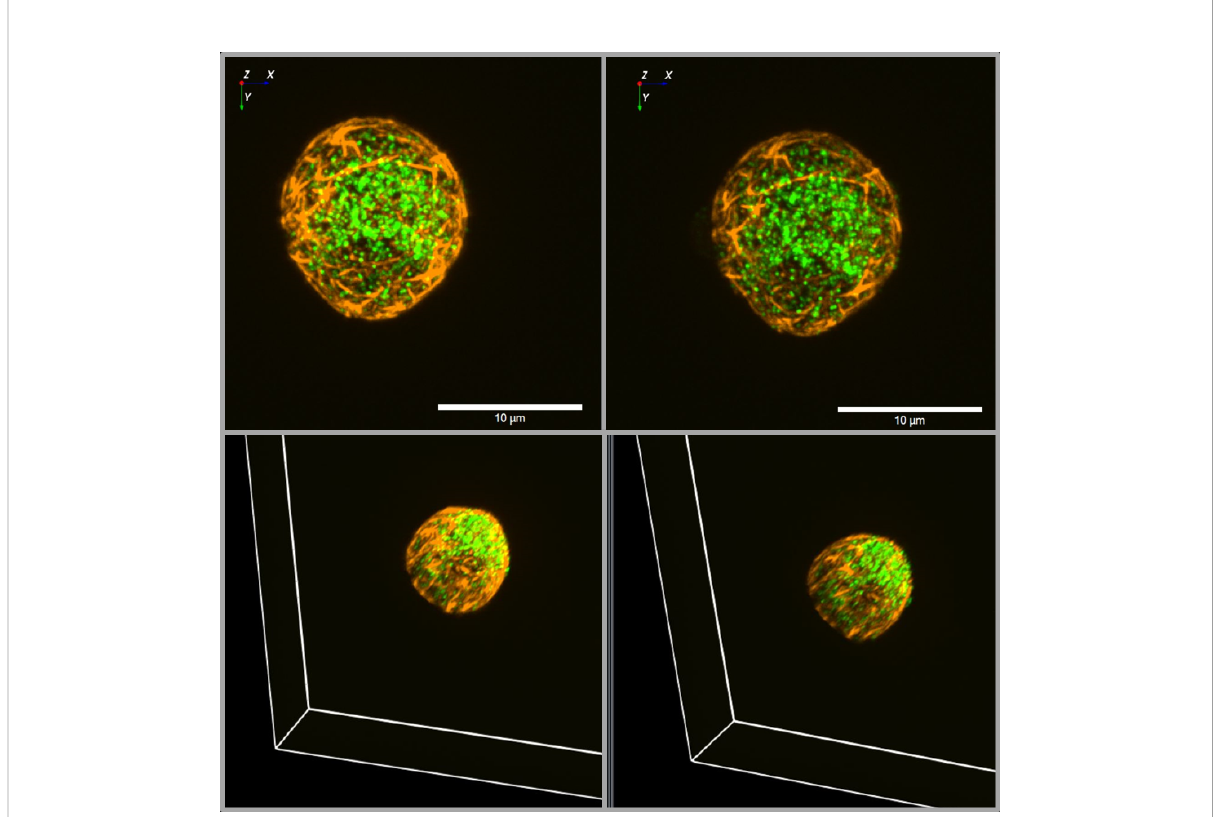
FIGURE 3 3D view of insulin granules and actin in primary beta cells. The insulin granules of primary beta cells were labeled by adenoviral transfection with hIns-EGFP (green) and mTagRFP-T-Lifeact-7 (orange). The fl uorescence was excited by spinning disk CLSM (50 µm disk, 2.8fold magni fi cation by SORA attachment, objective Nikon SR HP Apo TIRF 100x, N.A. 1.49). The z-stack was generated from 61 levels at 200 nm steps. The lower images show the same beta cell as above, but viewed from an oblique angle. The right images show the same cell as the left images